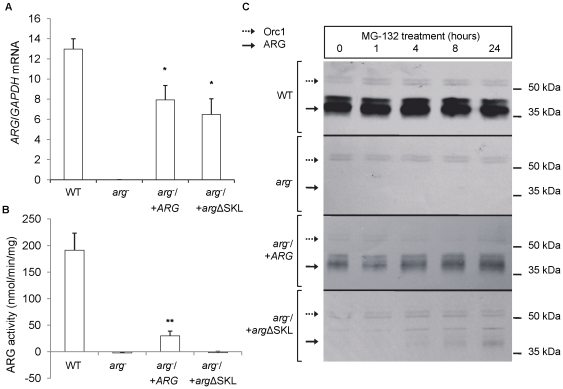

L. amazonensis ARG protein level and enzymatic activity are impaired by arginase mislocation.(A) ARG mRNA copies were determined by real time PCR and normalized by GAPDH mRNA copies for L. amazonensis wild type (WT), ARG knockout (arg
−), and the add-backs arg
−/+ARG and arg
−/+argΔSKL strains. The obtained values are the means (+/− SD) of at least 2 independent experiments each performed in duplicate. The values for arg
−/+ARG and arg
−/+argΔSKL are significantly different from those for arg
− and WT (p<0.0015*, t test). (B) ARG enzymatic activity from protein extracts of the same strains was determined and is expressed as nmol/min/mg. The obtained values are the means (+/− SD) of 3 independent experiments each performed in triplicate. The values for arg
−/+ARG are significantly different from those for arg
− and arg
−/+argΔSKL (p<0.0001**, t test). (C) ARG and Orc1 (loading control) levels were determined by western blotting of total cell lysates from the same strains before and after treatment with MG-132 50 µM for 24 hours.